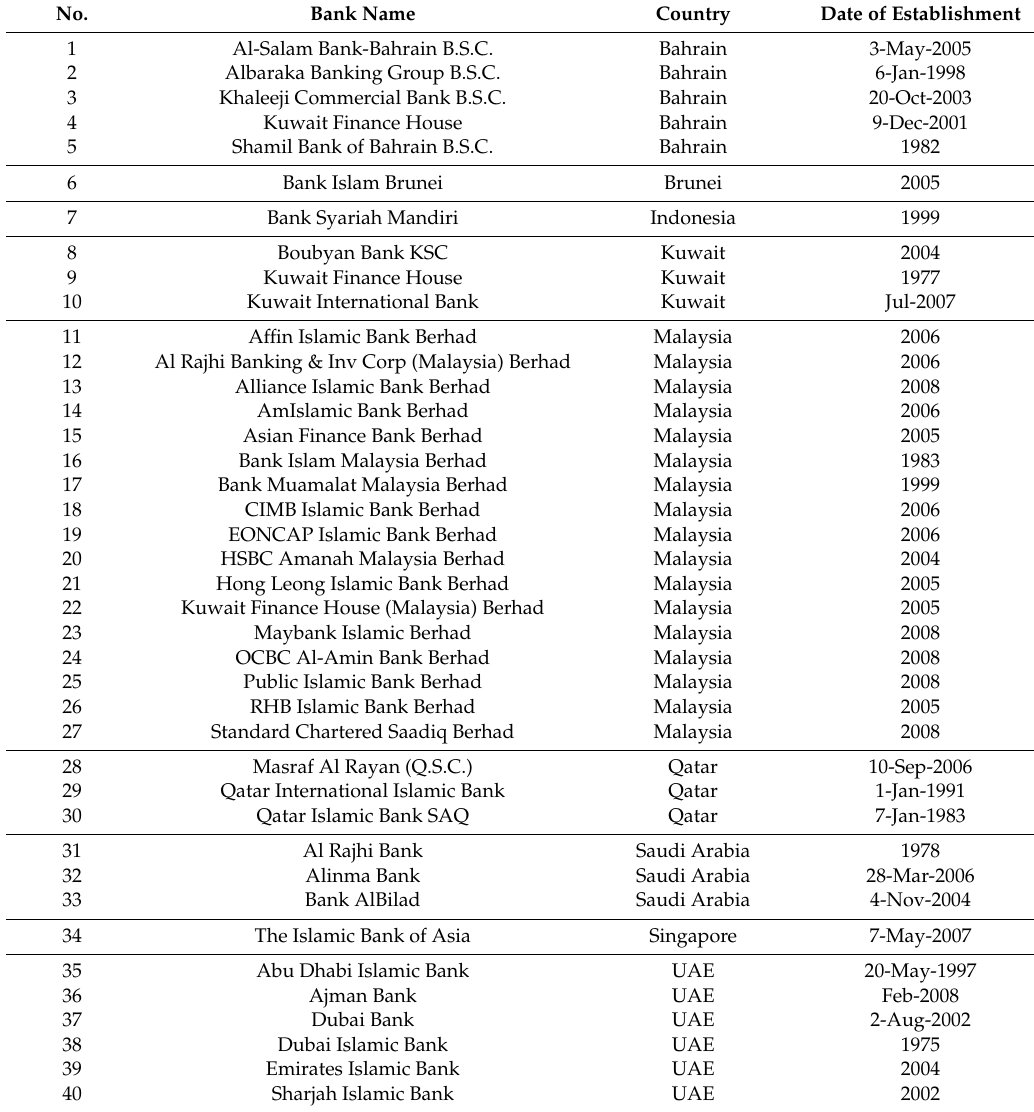
Table A2. Details of the Sample Islamic banks.